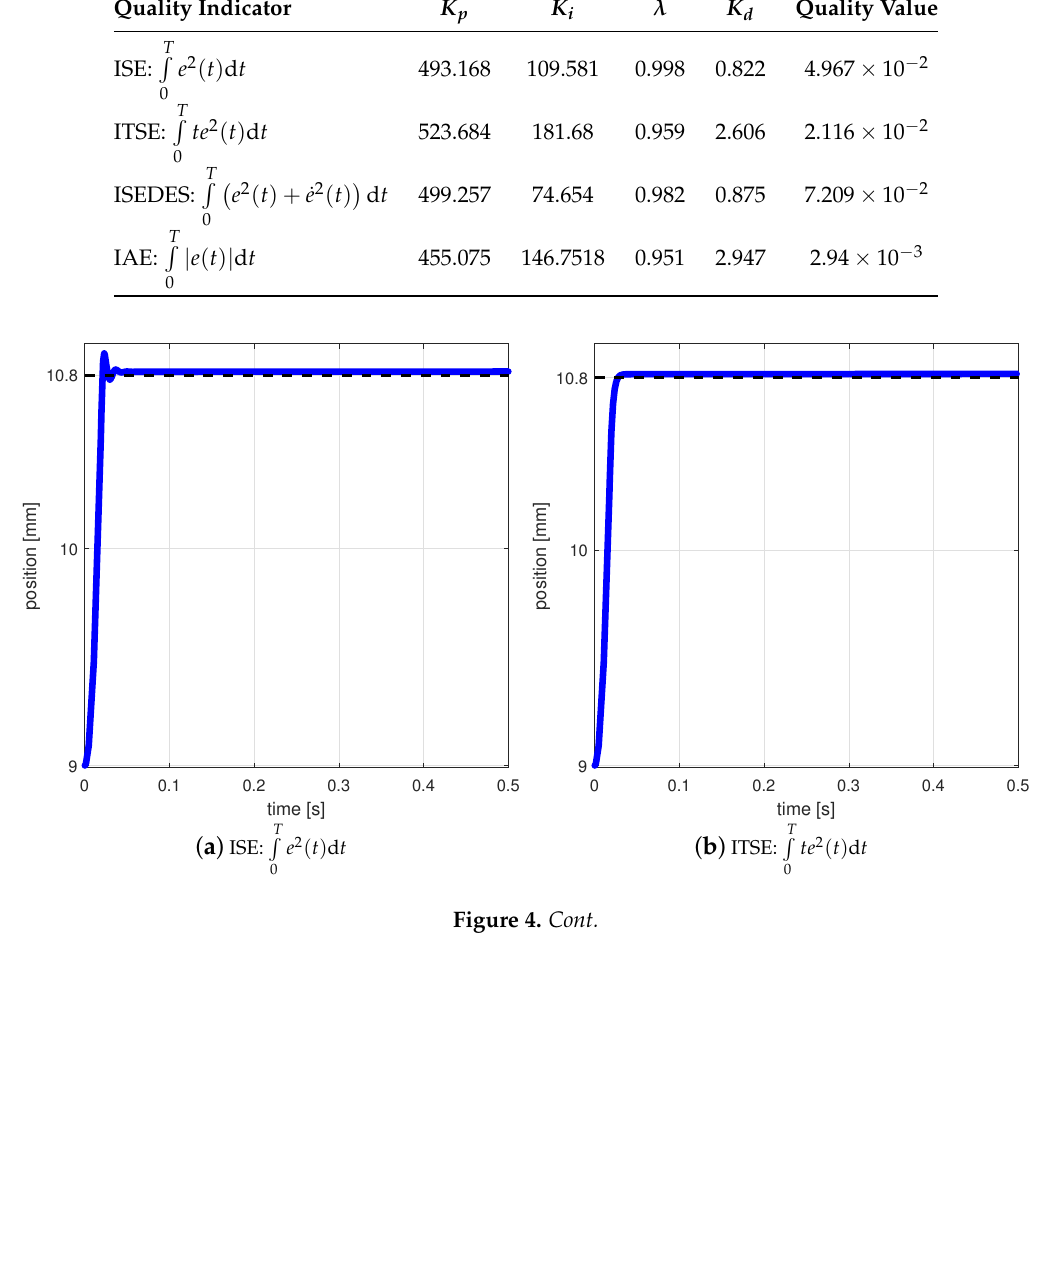
Table 2. Result of tuning system using simulated annealing. The values of the λ parameter are similar in all cases. The ITSE indicator sets the highest gain for proportional and integral parts of the regulator. In contrast, the IAE indicator sets much lower gains on these parts, but similar gains on the derivatives. It does not change the fact that the quality indicators assume values from a similar range. The ISE and ISEDES indicators set a similar gain of proportional and derivative parts. On the other hand, ISEDES is a weaker integrator gain and therefore gives the worst final value of the quality indicator. Quality Indicator K p K i λ K d Quality Value